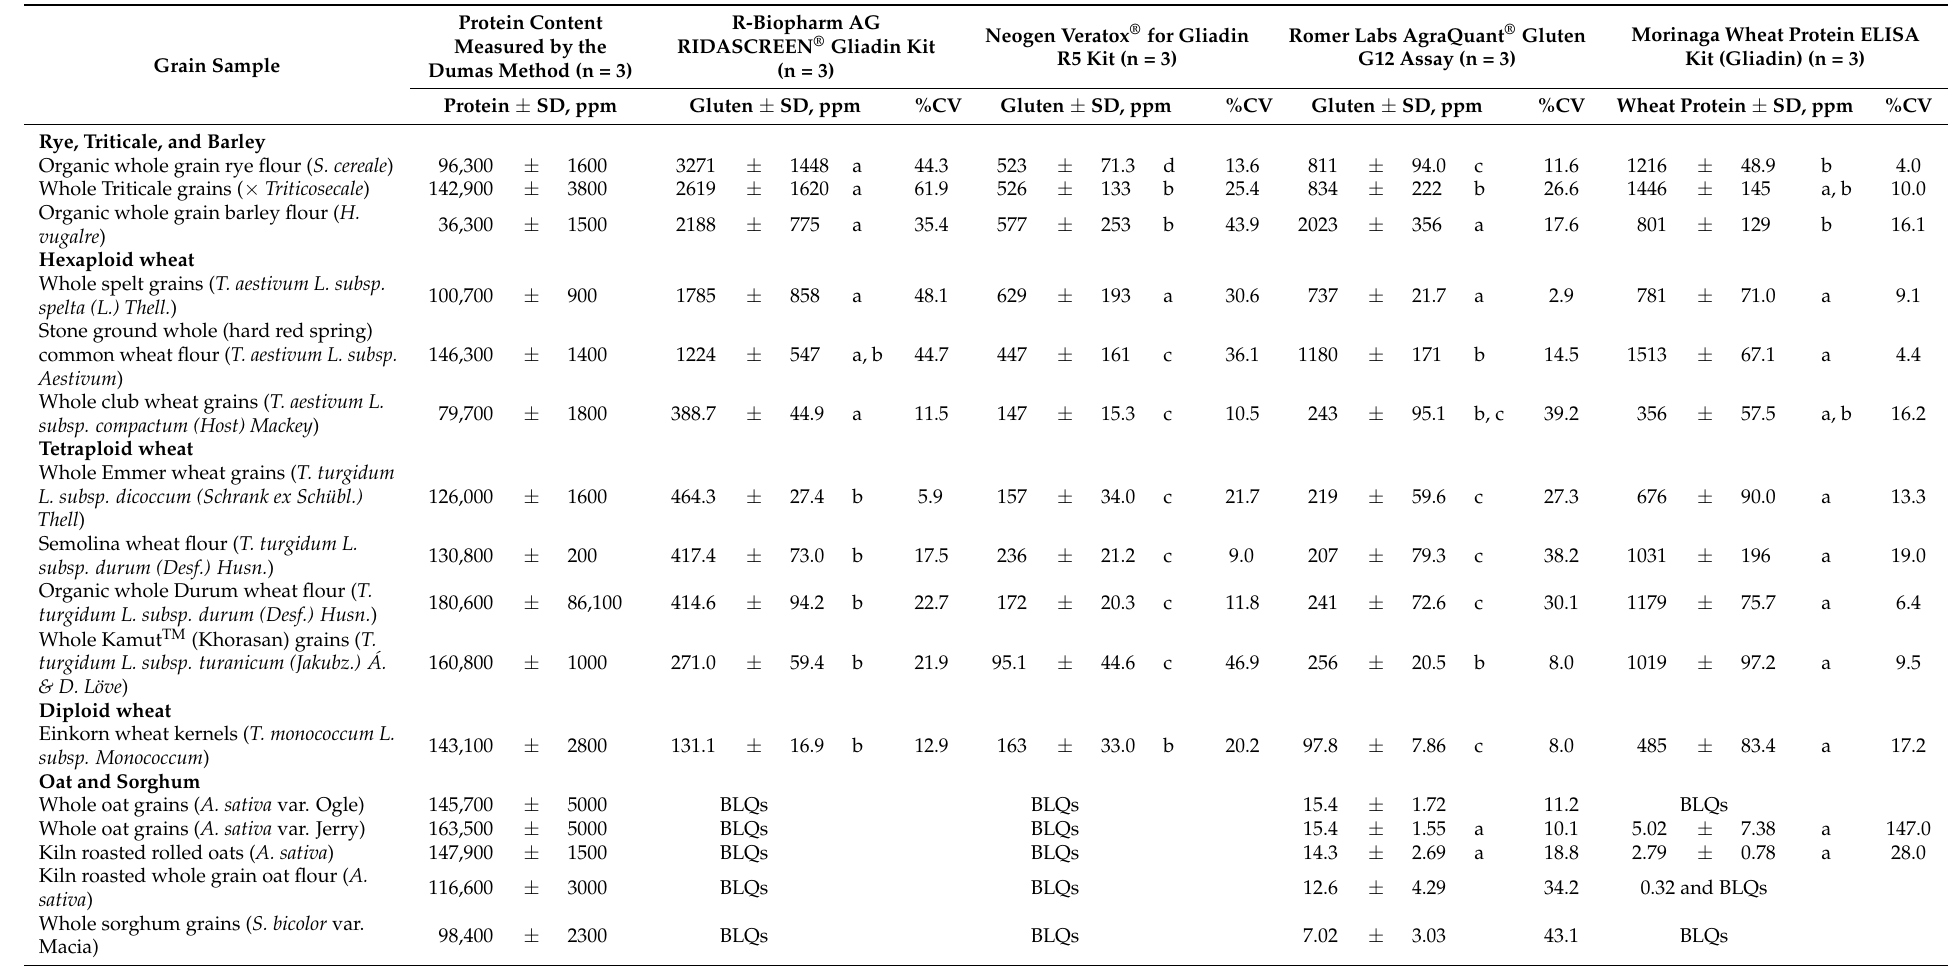
Table 3. Analysis of gluten/wheat protein in cereal grains by the four commercial sandwich ELISA